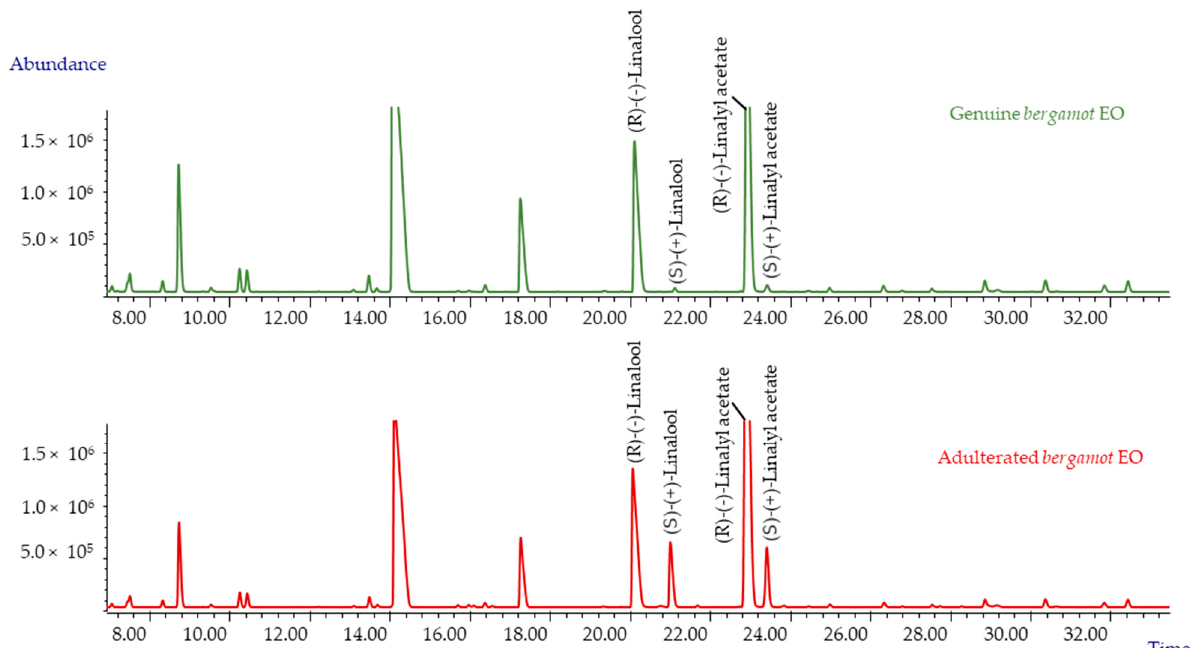
Figure 2. Linalool and linalyl acetate in a genuine and an adulterated bergamot EO analysed with a 2,3DE6TBDMS- β -CD chiral column phase.